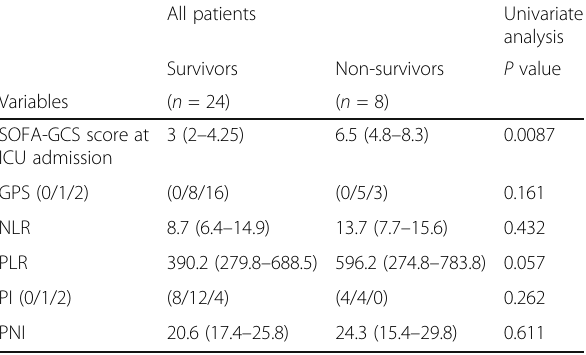
Table 3 Inflammation-based prognostic scores All patients